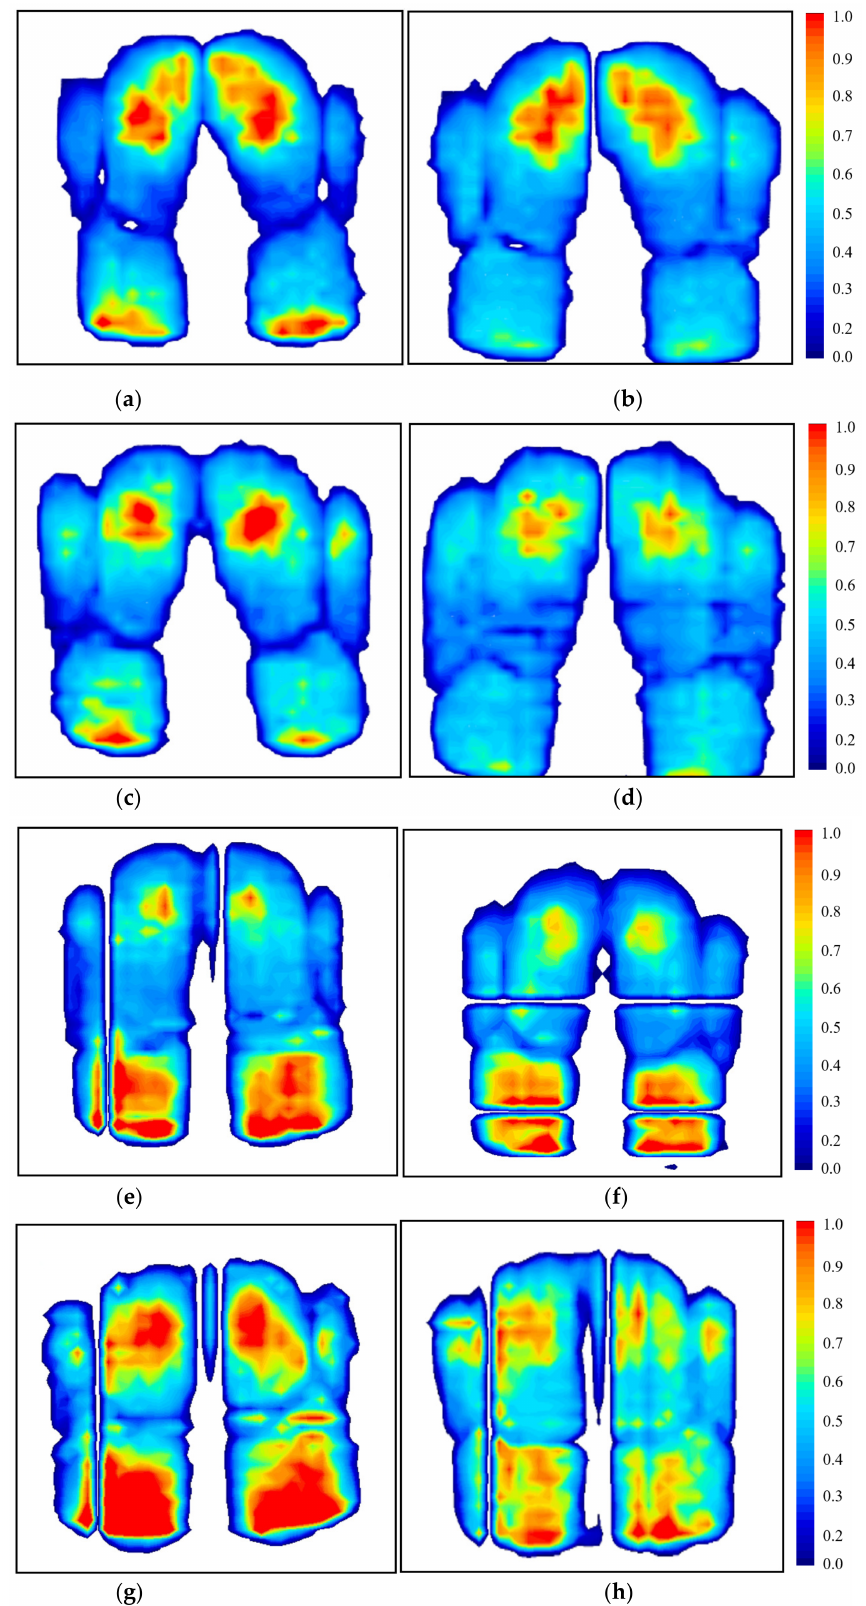
Figure 15. Seat cushion test pressure map: ( a ) Subject 1, original sponge; ( b ) Subject 1, improved sponge; ( c ) Subject 2, original sponge; ( d ) Subject 2, improved sponge; ( e ) Subject 3, original sponge; ( f ) Subject 3, improved sponge; ( g ) Subject 4, original sponge; ( h ) Subject 4, improved